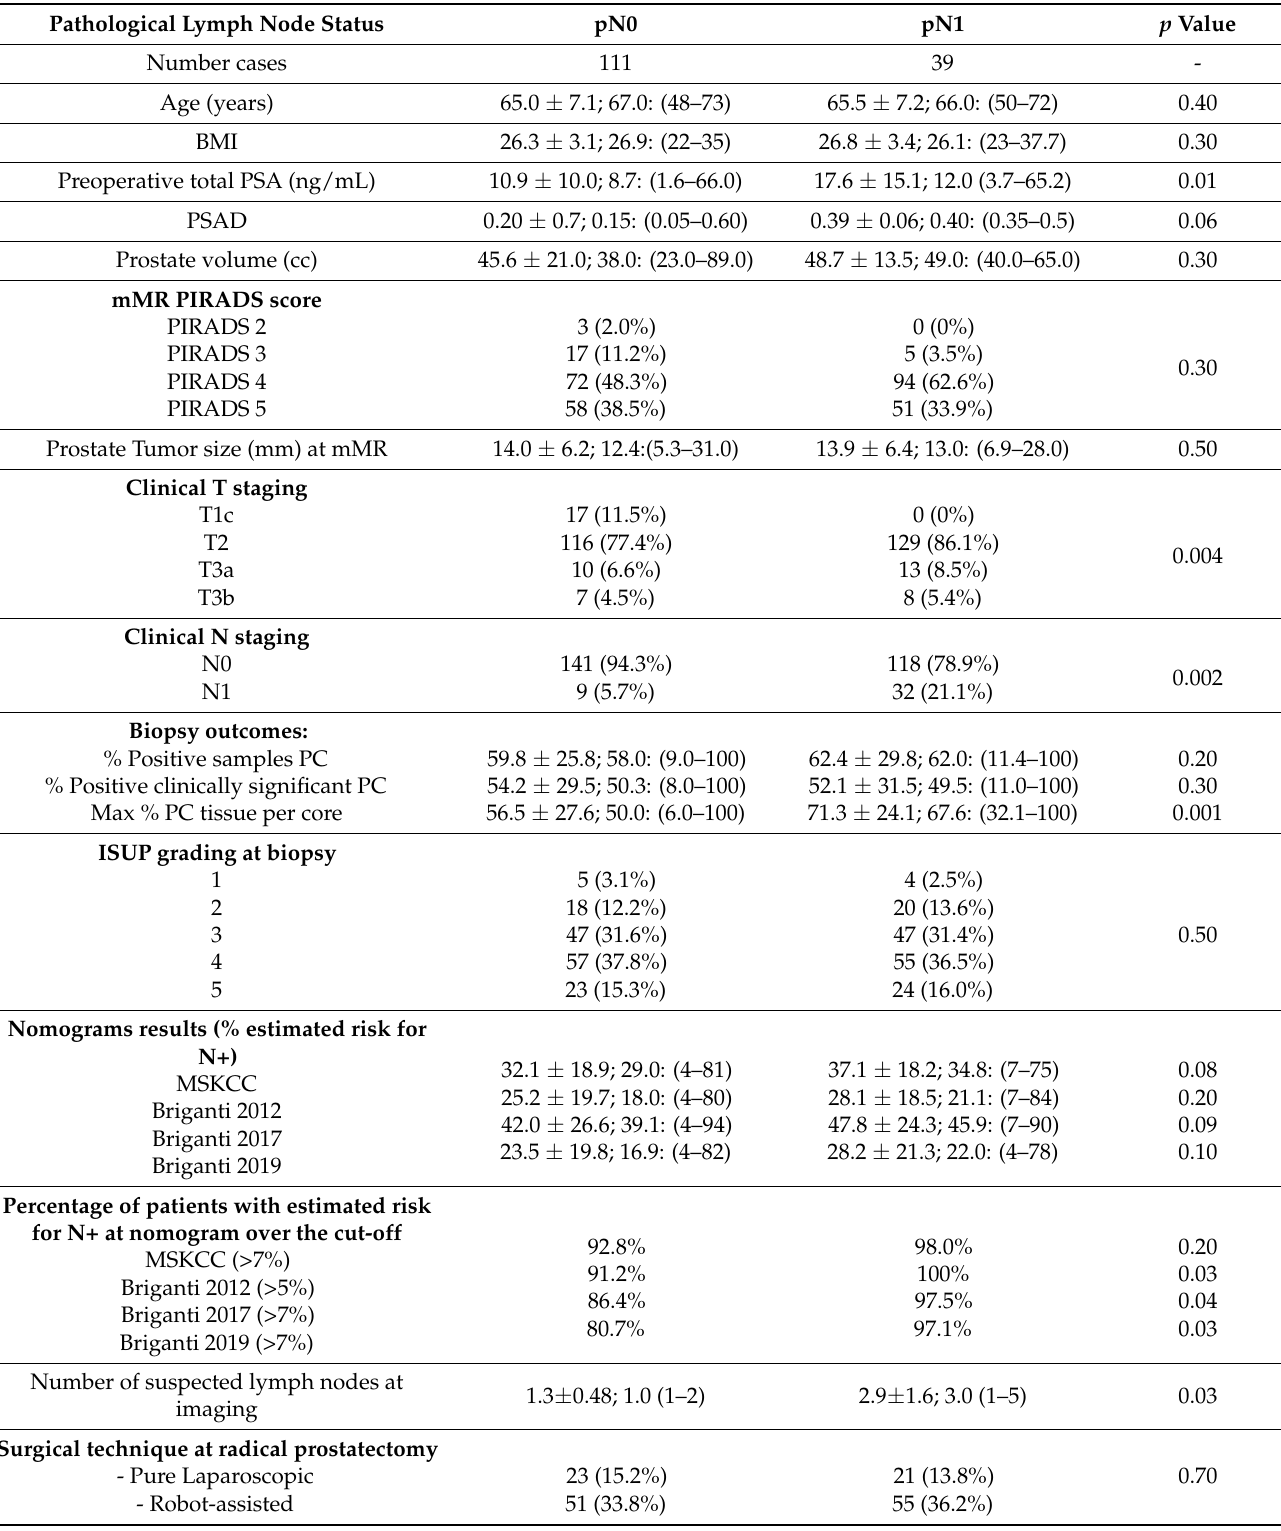
Table 2. Comparative analysis based on pN